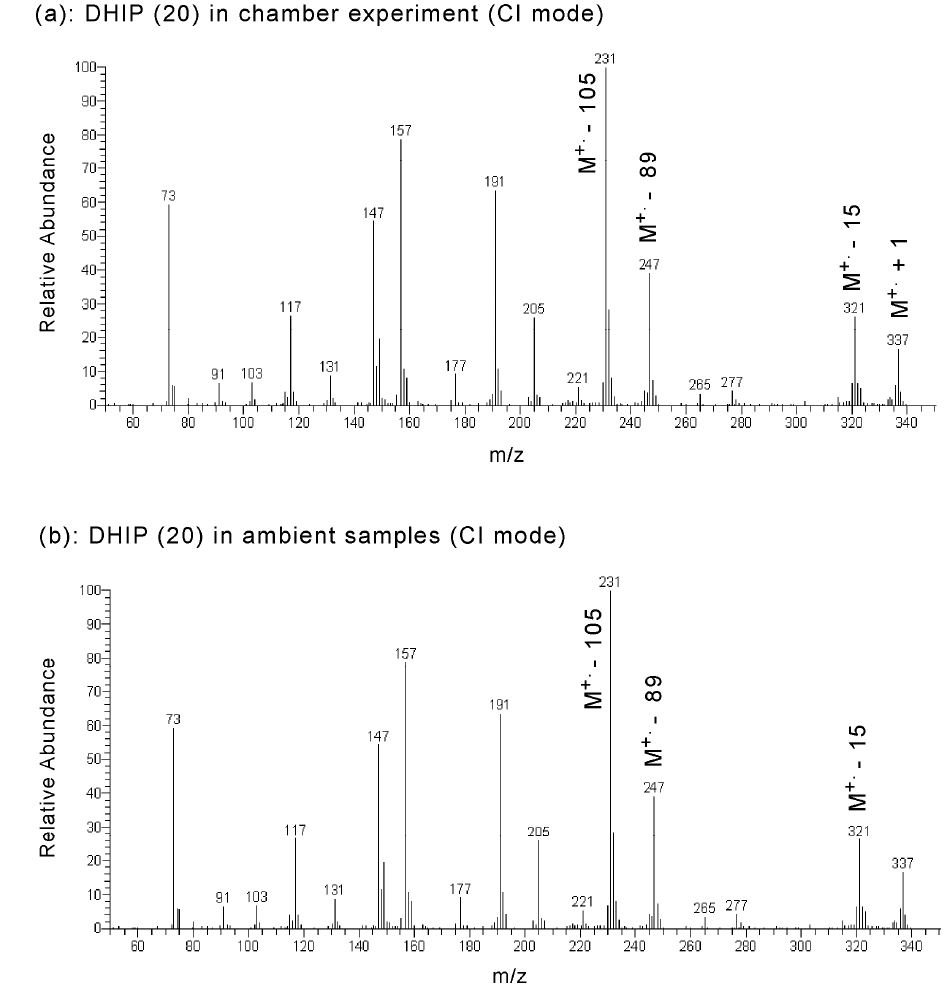
Fig. 7. Mass spectrum of the BSTFA derivative of DHIP (20) in CI mode observed in a chamber experiment (a) and in ambient samples (b).